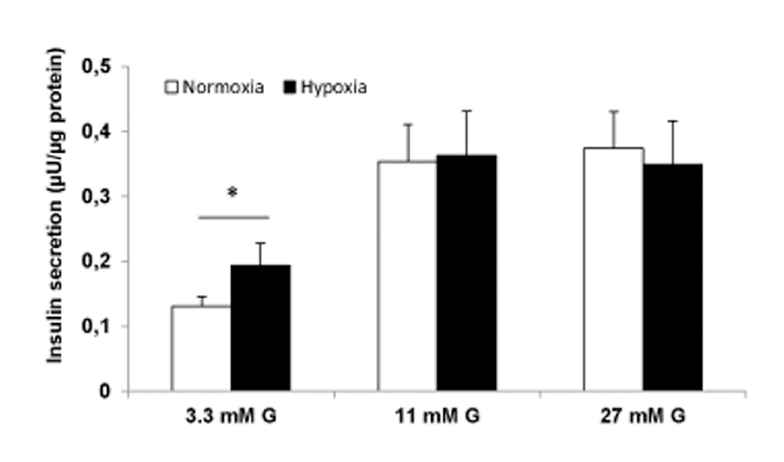
Fig 2. Previous hypoxia (8 hours) increased basal but not stimulated insulin secretion in INS-1 832/13 cells. Insulin release (final 60 – 90 min incubations) with 3.3, 11 and 27 mM glucose (G). Protein content was estimated from a mean of three measurements in each experiment. Data are mean ± SEM, n = 5, * P <